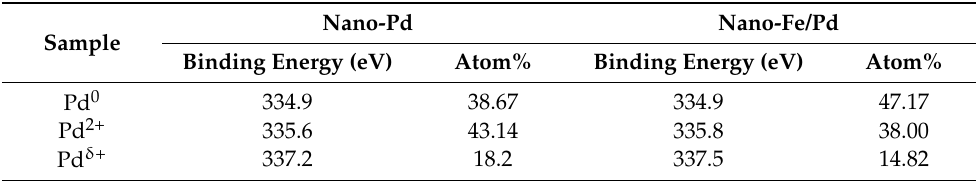
Table 1. Relative atomic concentration (%) of Pd in the samples by XPS